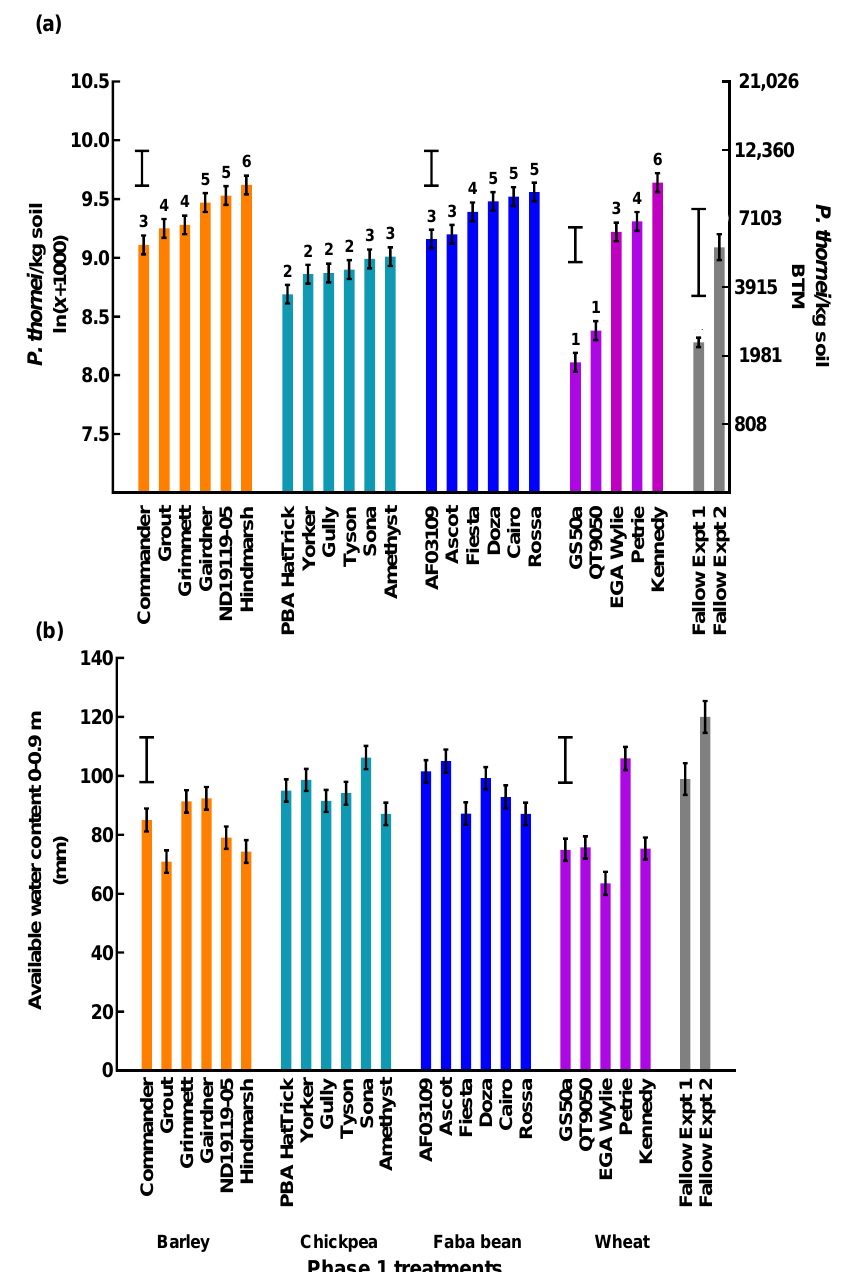
Figure 2. ( a ) Pratylenchus thornei /kg soil and ( b ) available water content (mm) at 0–0.9 m soil depth, 6 months after harvest of the Phase 1 treatments (2 months prior to sowing the Phase 2 wheat). For cultivars, means are for the combined experiments (bar markers above the crop groups indicate l.s.d. ( p = 0.05) for cultivars within crop; crop groups with no bar marker indicates no significant difference between cultivars p > 0.05), n = 12; number above the bars in ( a ) indicates the fold change in population densities above the wheat cv. GS50a. For the weed-free fallow treatment, means are for each experimental site, n = 6. Error bars indicate standard error of the mean. BTM, back-transformed means; Expt, Experiment.